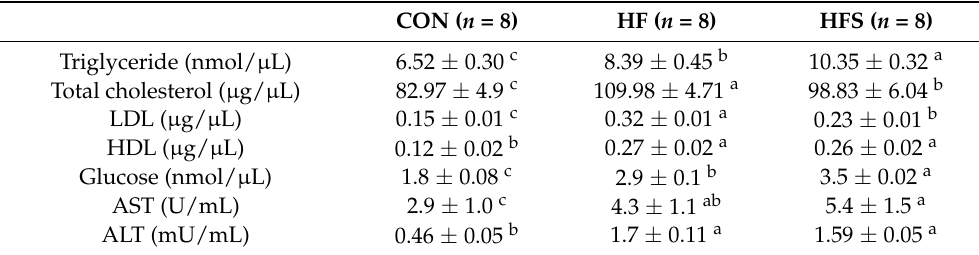
Table 3. Levels of serum triglyceride, total cholesterol, LDL, HDL, glucose, AST, and ALT in mice fed a conventional normal, HF, and HFS